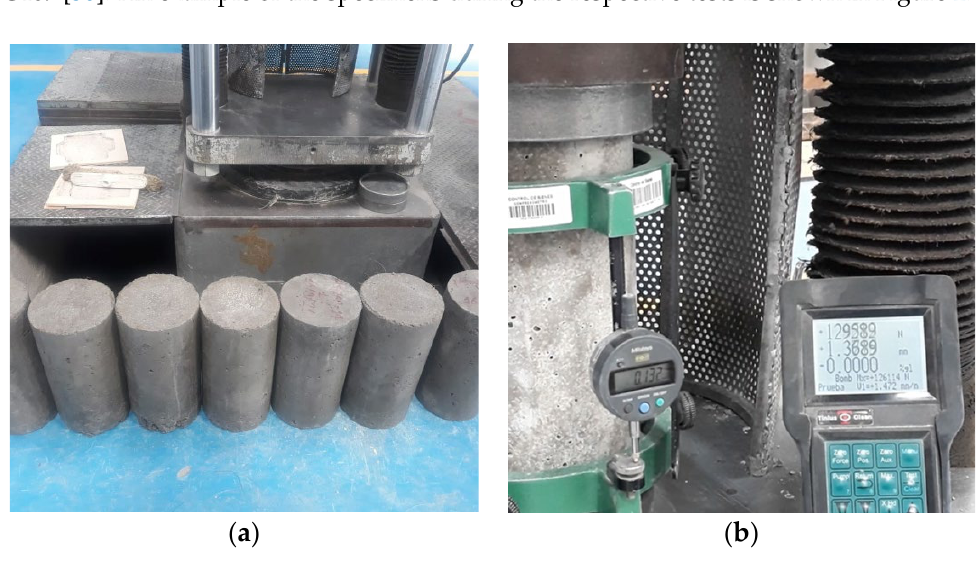
Figure 2. ( a ) Specimen for compression test, and ( b ) modulus of elasticity